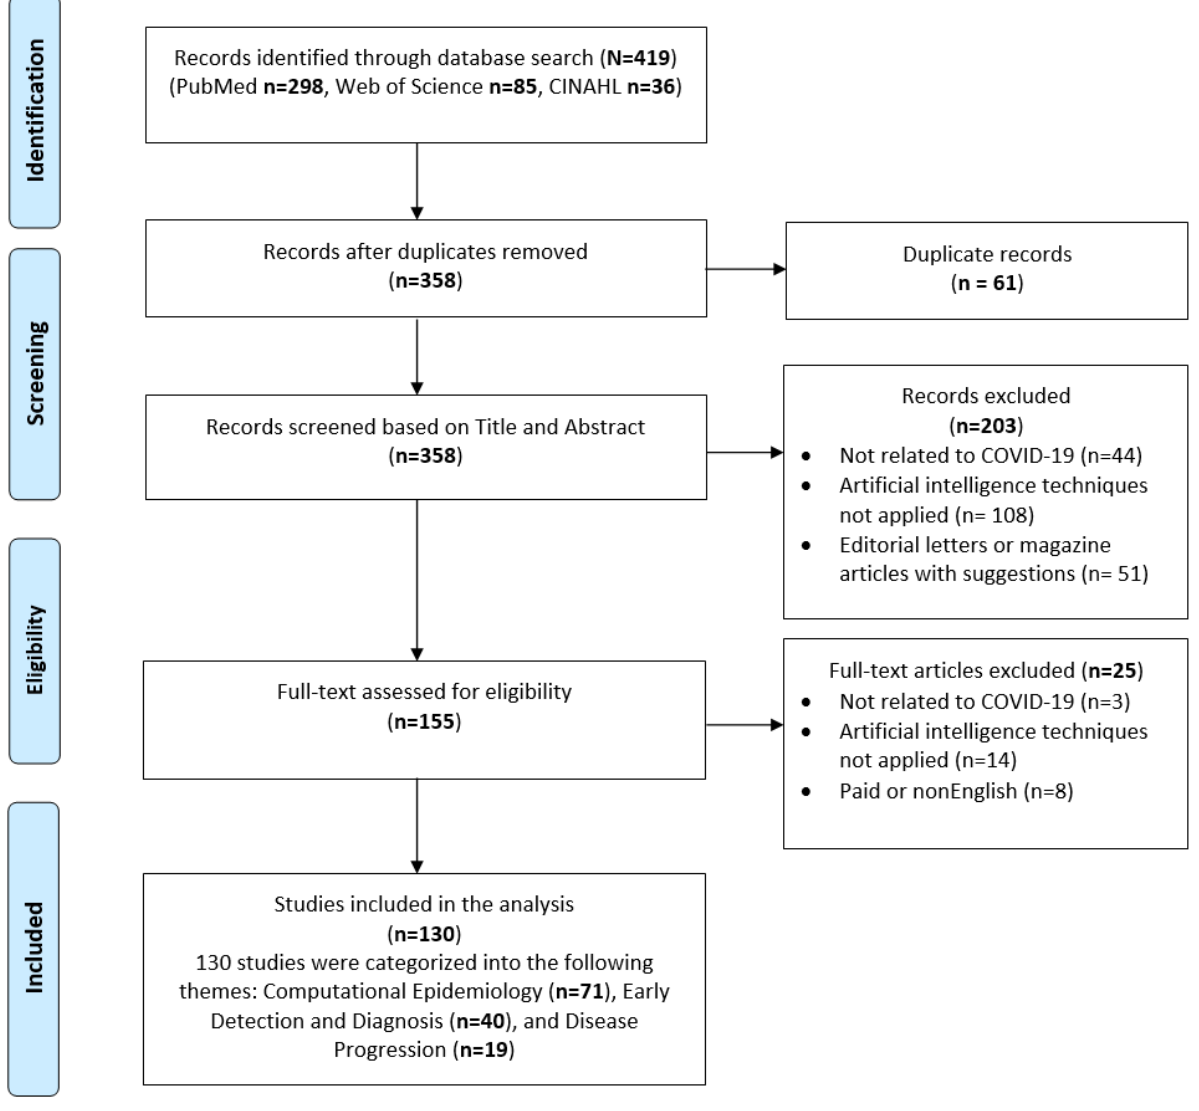
Figure 1. PRISMA (Preferred Reporting Items for Systematic Reviews and Meta-Analysis) flow diagram of systematic identification,